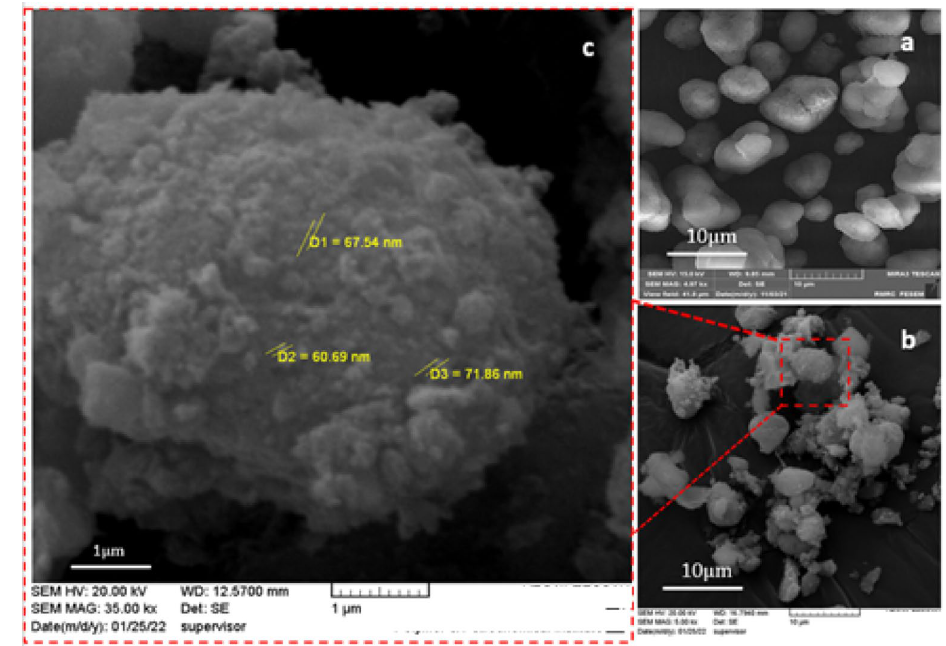
Figure 2. SEM images of ( a ) boehmite, ( b , c ) B-V-PIL/W.